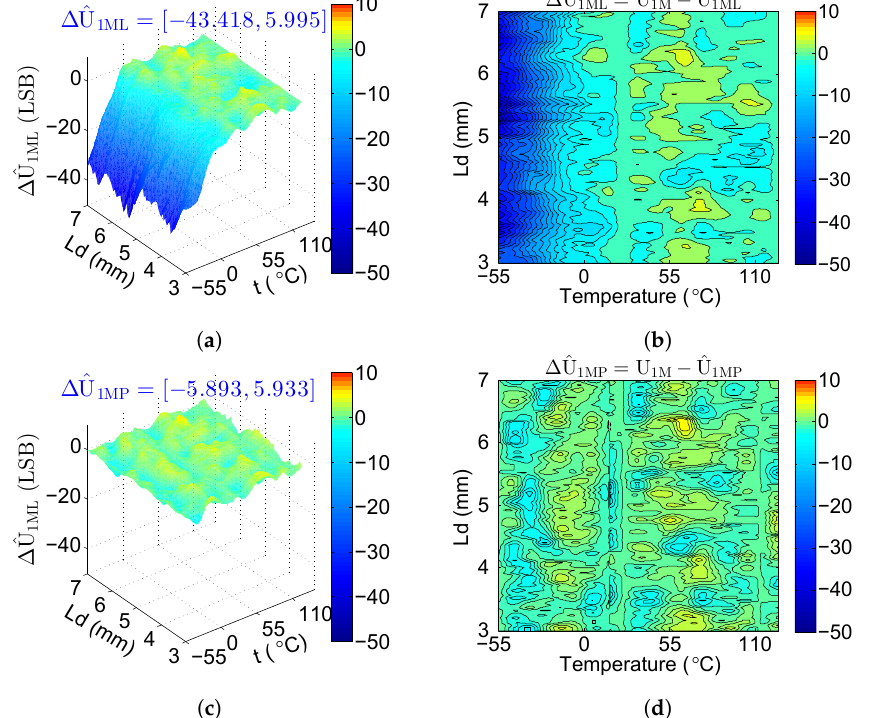
Figure 12. ∆ ˆU 1ML with different { L x ,t } displayed by: ( a ) 3D map; ( b ) contour map; ∆ ˆU 1MP with different { L x ,t } displayed by: ( c ) 3D map; ( d ) contour map (the blue color of the areas at a low temperature in ( a , b ) changes into green color in ( c , d ), which indicates that ∆ ˆU 1MP is closer to zero than ∆ ˆU 1ML ). Table 5. Comparison of statistical values ∆ ˆU 1ML and ∆ ˆU 1MP (the values of ∆ ˆU 1MP are much less than ∆ ˆU 1ML , especially the minimum values, thereby demonstrating that the proposed system can obtain more accurate distance